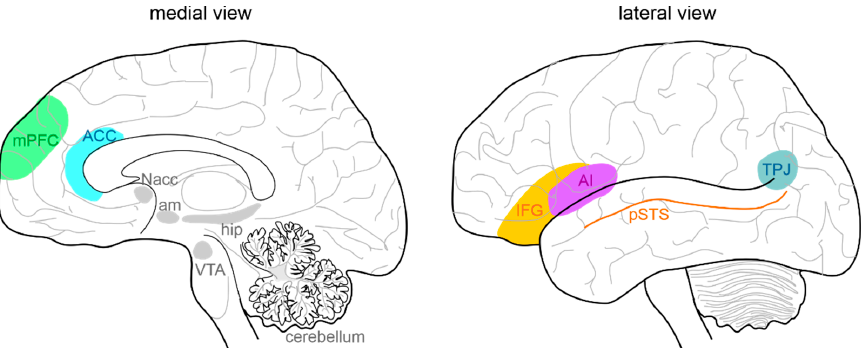
Figure 1. Anatomy of the social brain. The main brain areas involved in the “social brain” are re- ported in the medial ( left ) and lateral ( right ) schematic view of the human brain: medial prefrontal cortex (mPFC), anterior cingulate cortex (ACC), temporo-parietal junction (TPJ), posterior superior temporal sulcus (pSTS), inferior frontal gyrus (IFG), and anterior insula (AI). The main regions con- nected to the “social brain” are reported in grey: hippocampus (hip), amygdala (am), ventral teg- mental area (VTA), nucleus accumbens (NAcc), and cerebellum.